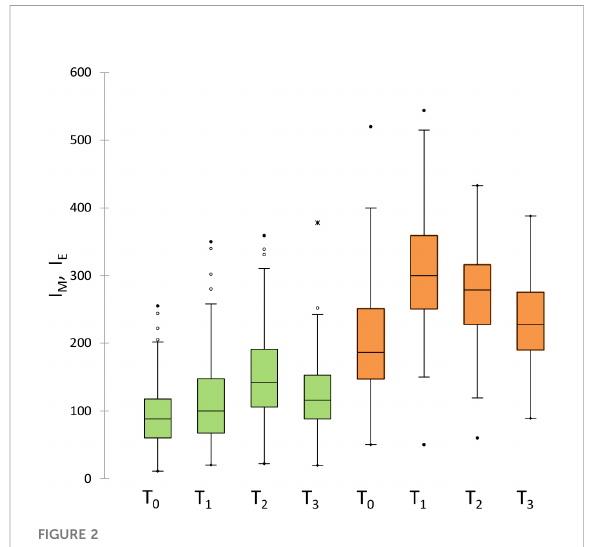
FIGURE 2 Measured values of melanin (green) and erythema (orange) indexes before (T0) and after different times (T1, T2 and T3) after radiotherapy. Data are reported as box-and-whisker